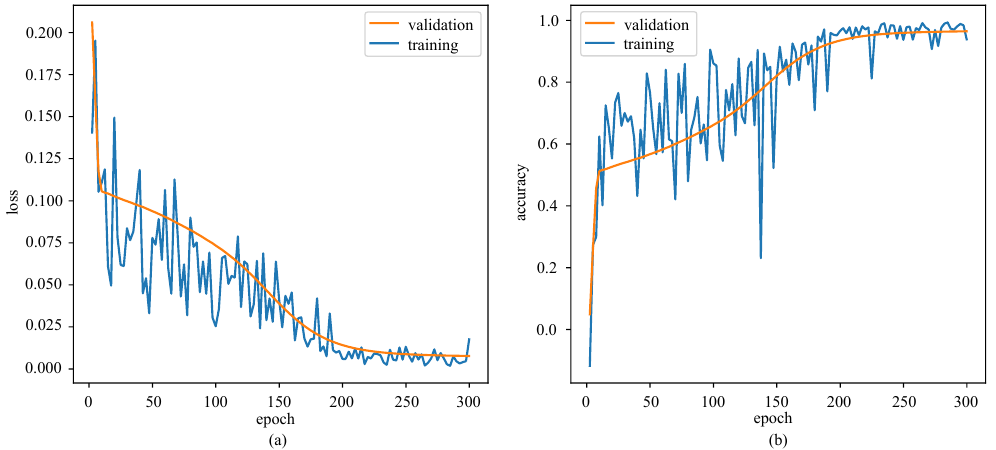
Figure 7. The loss function changes ( a ) and accuracy changes ( b ) over different epoches in training the music emotion representation model.